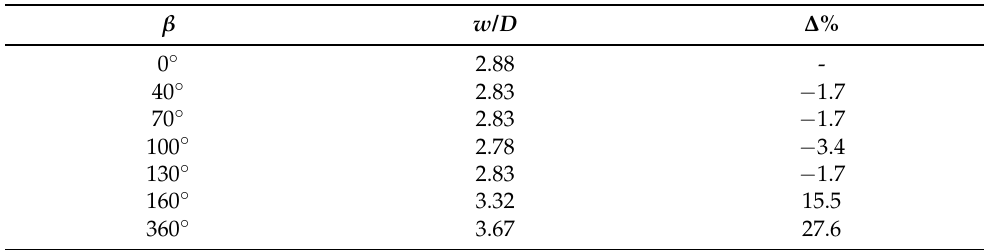
Table 3. Comparison of the normalised wake widths w / D for the varying porous coating angles and the smooth cylinder ( β = 0 ◦ ).